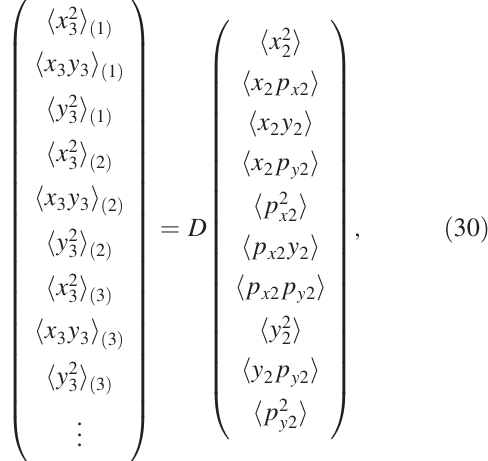
FIG. 4. Simulation of three-screen analysis technique for measurement of vertical emittance and optical functions, using (left) a Gaussian elliptical phase space distribution, and (right) a realistic phase space distribution constructed from the results of the tomography analysis presented in Sec. III C. The plots show the same quantities as the corresponding plots in Fig. 3. Note that for the Gaussian elliptical distribution, there is only a very small variation in each quantity with change in the quadrupole strengths, but the realistic phase space distribution shows a similar variation as the experimental case (Fig. 3). The Gaussian elliptical distribution was constructed with nominal